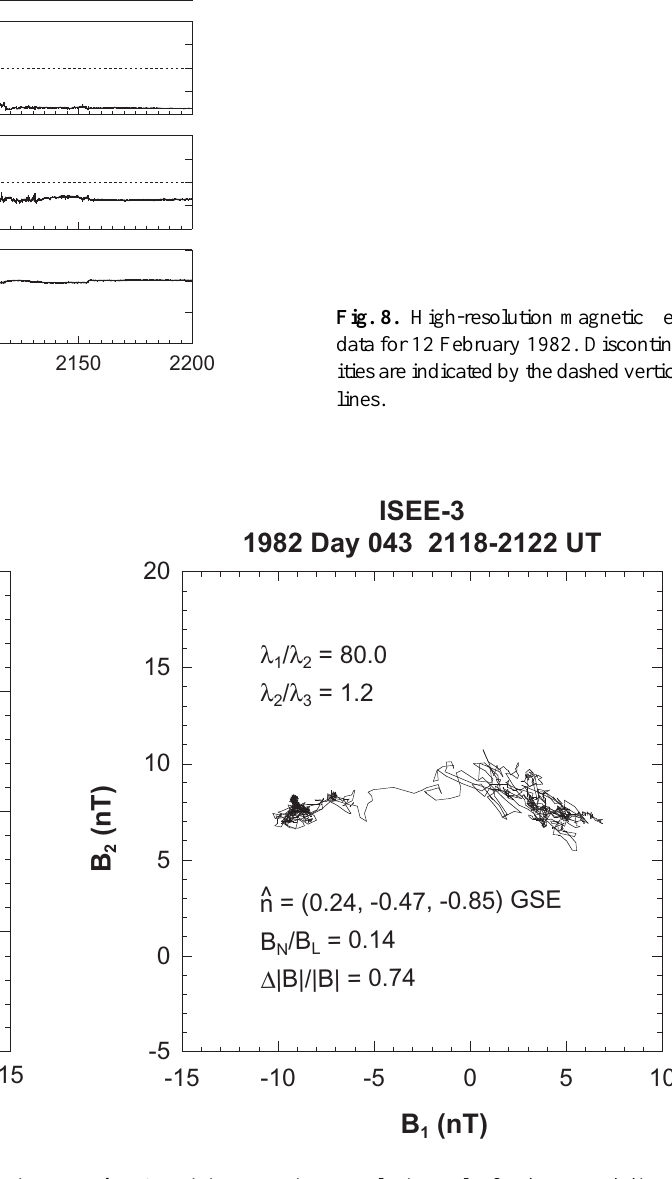
Fig. 10. Minimum variance analysis results for the second discon- tinuity in Fig. 8. The coordinate definition is the same as that in Fig.